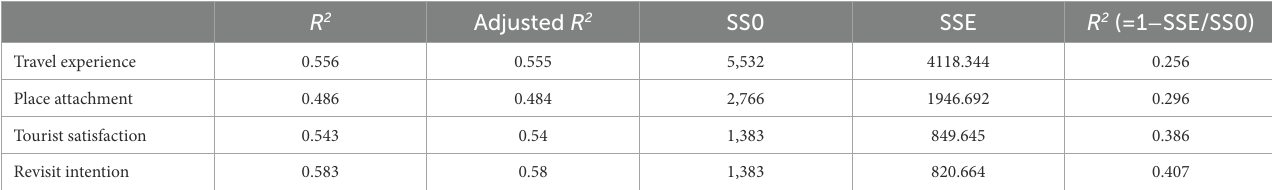
TABLE 5 The explanatory power and predictive correlation